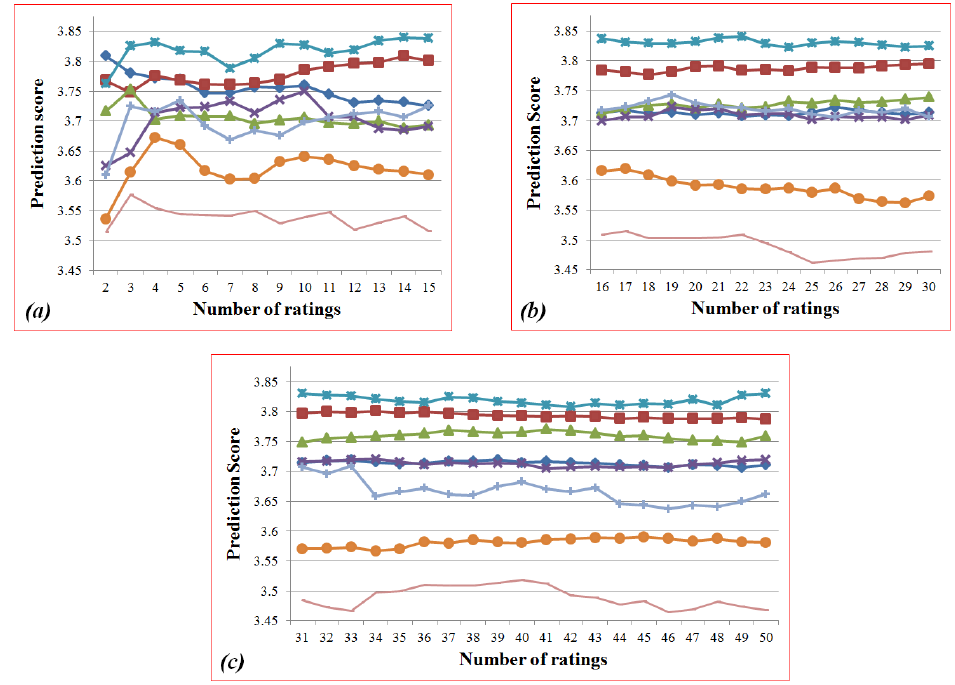
Figure 3. Sub-graphs of Figure 2: ( a ) the ranges from 2 to 15; ( b ) from 16 to 30; ( c ) from 31 to 50.